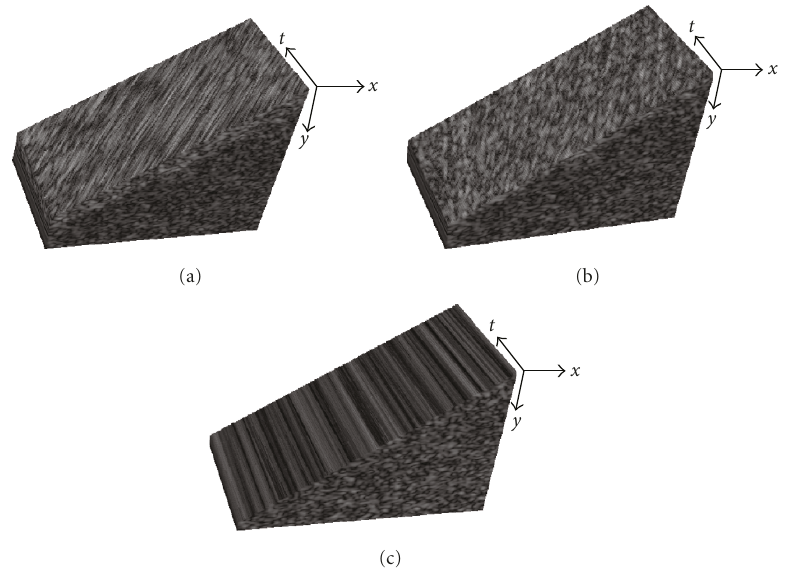
Figure 4: Tilted spatiotemporal planes extracted from the 2D+t data volume at several depths: (a) at the center of the vessel (maximum velocity), (b) close to the border of the vessel (minimum velocity), (c) outside the vessel (no velocity).